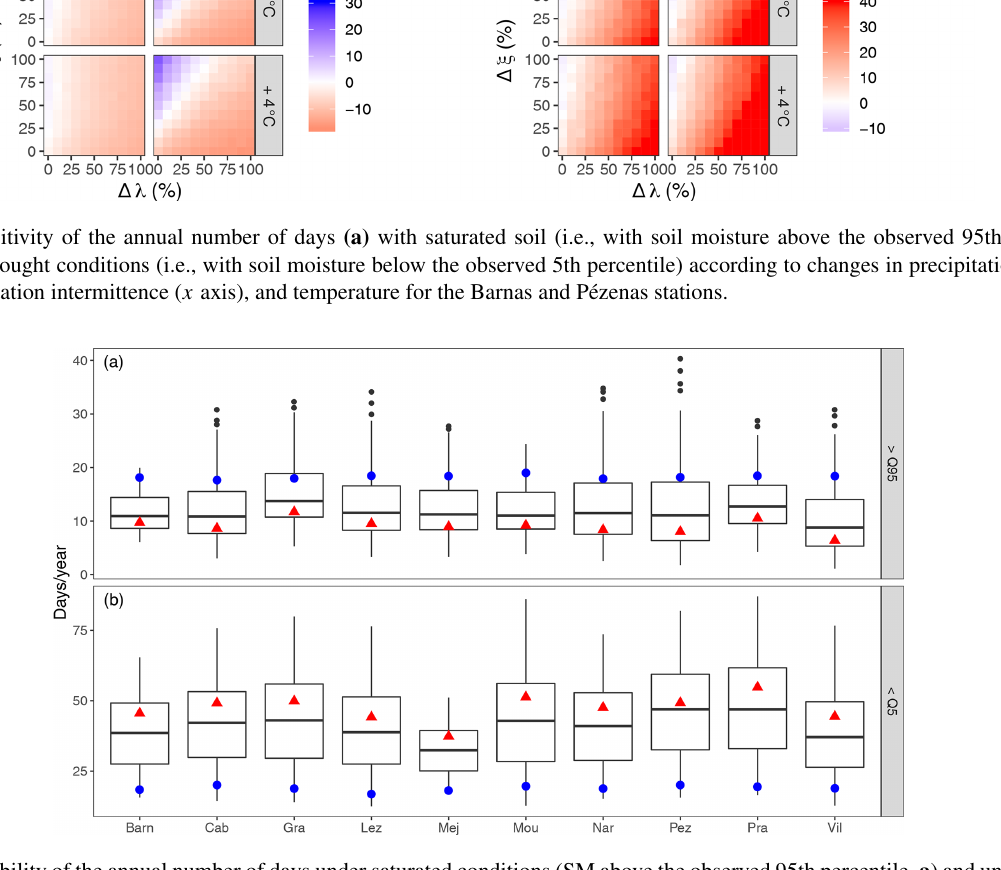
Figure 12. Variability of the annual number of days under saturated conditions (SM above the observed 95th percentile, a ) and under drought conditions (SM below the observed 5th percentile, b ) at each station for a + 4 ◦ C temperature scenario. Boxplots represent the results for all precipitation scenarios with increasing precipitation intensity and intermittence. Blue dots represent the reference scenario, with no change in temperature or precipitation pattern. Red triangles represent the mean of the scenarios with a decrease of annual precipitation between − 10% and − 20% (corresponding to scenario RCP8.5; Polade et al.,